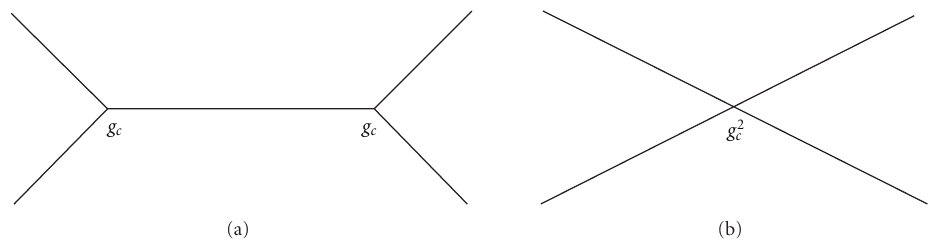
Figure 2: Diagrammatic representations of the tree-level contributions to the vector fields trispectrum: vector-exchange (a) and contact- interaction (b)